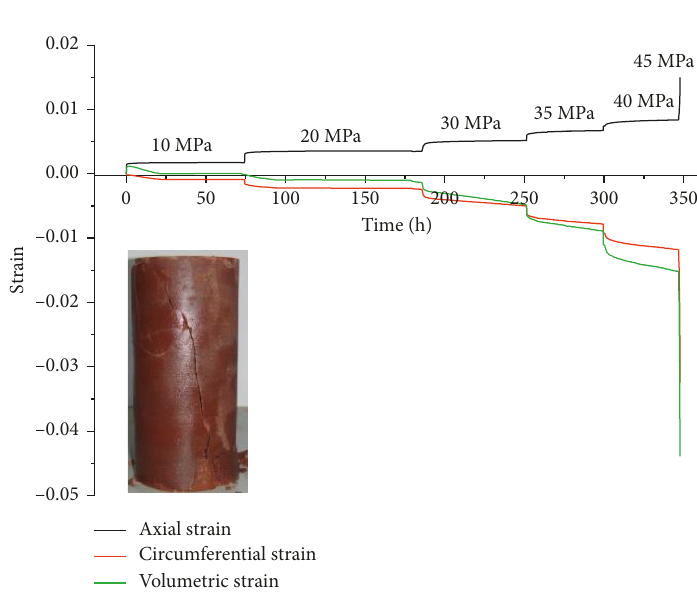
Figure 2: Strain of mudstone over time (under dry condition).